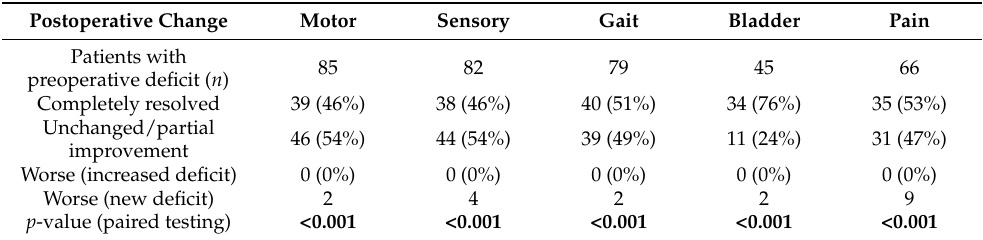
Table 5. Change in neurological status following